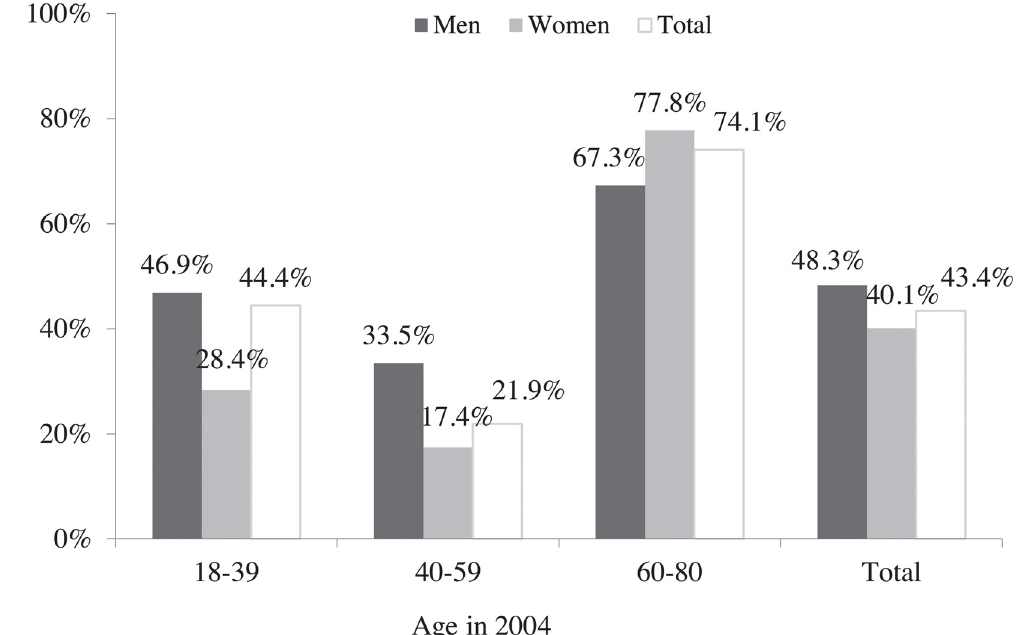
Fig 2. Estimated proportion of undiagnosed among chronically-infected HCV population by gender and age-group in 2004, mainland